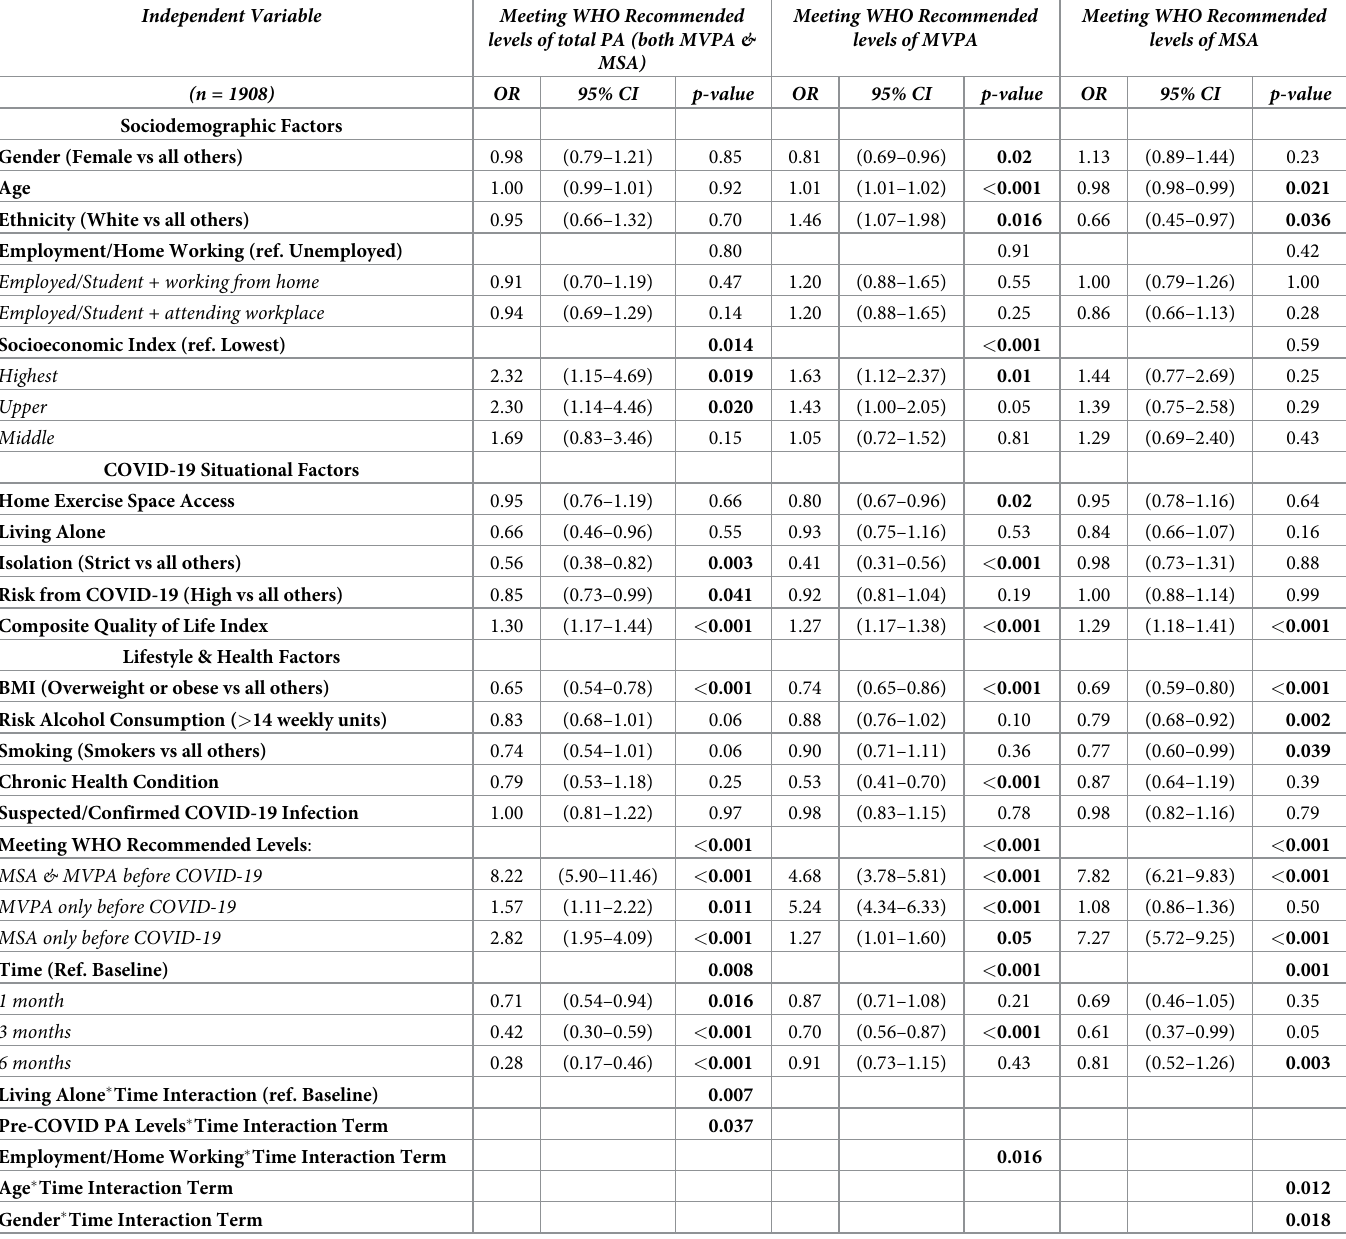
Table 2. Factors associated with meeting WHO recommended levels of PA throughout the COVID-19 pandemic. Independent